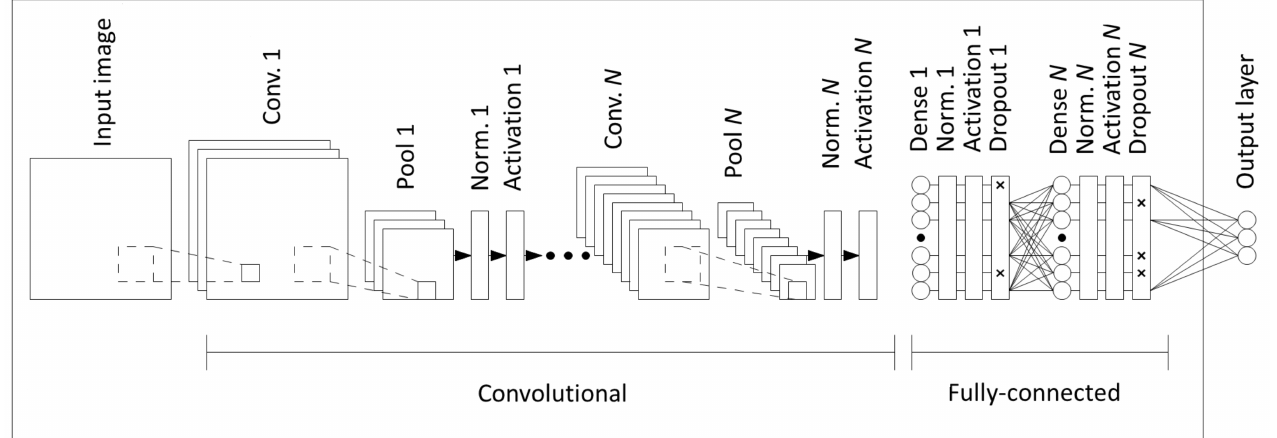
Figure 3. Base architecture of the convolutional neural networks in which Sentinel-2 information was used to model tree species community composition in Forest Resource Inventory or field data from south-central Ontario, Canada. A series of standard computational layers were pipelined, including convolution, pooling, normalization, dense, and dropout layers, and with various possible activation functions between layers (see text for details). Final model architectures and parameterizations were based on Bayesian hyper-parameter searches (see Supplementary Materials Table S2). Modified from Figure 4 in